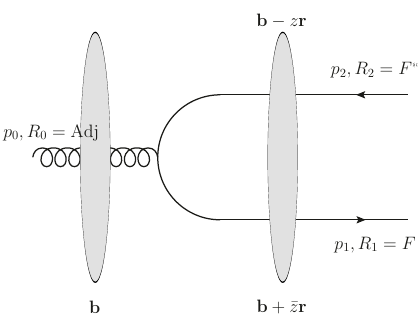
q ¯ q amplitude in an external shockwave background with the appropriate color →